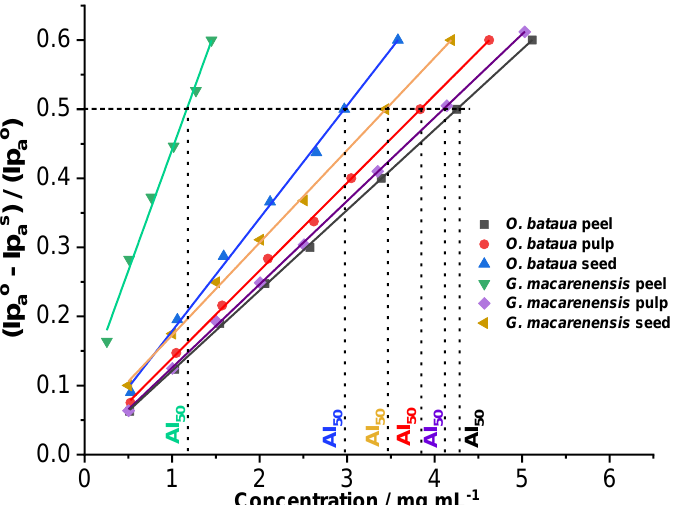
Figure 2. Plots of the dimensionless parameter ( ( Ip 0 a − Ip s a ) / Ip 0 a ) vs. substrate concentration for O. Bataua and G. macaranensis.